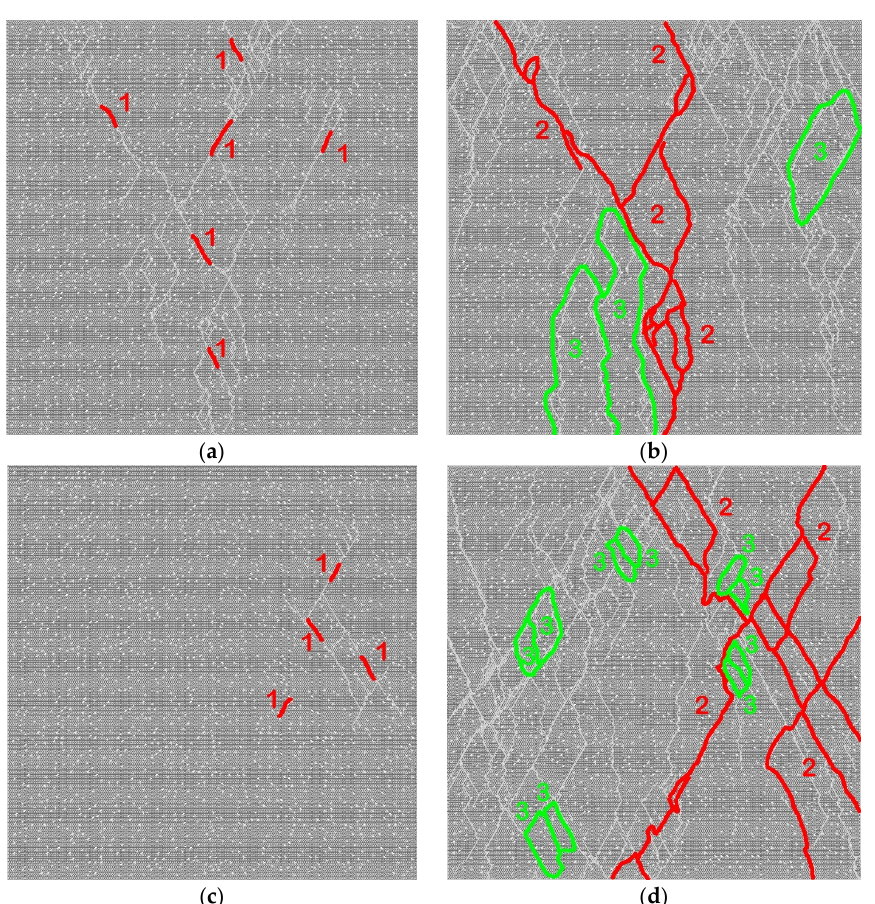
Figure 8. Fracture of model water-saturated samples of cement stone with a two-scale pore structure at different values of Da : 0.5 ( a , b ); 140 ( c , d ). Figures ( a , c ) show the beginning phase of fracture, while figures ( b , d ) show broken samples. Primary short cracks originating from damage to the mesopore walls are shown in ( a , c ). They are marked by the red lines and indicated by the number 1. The main cracks in ( b , d ) are marked by the red line and indicated by the number 2. Some typical non-equiaxial fragments are bordered with green contours and indicated by the number 3.